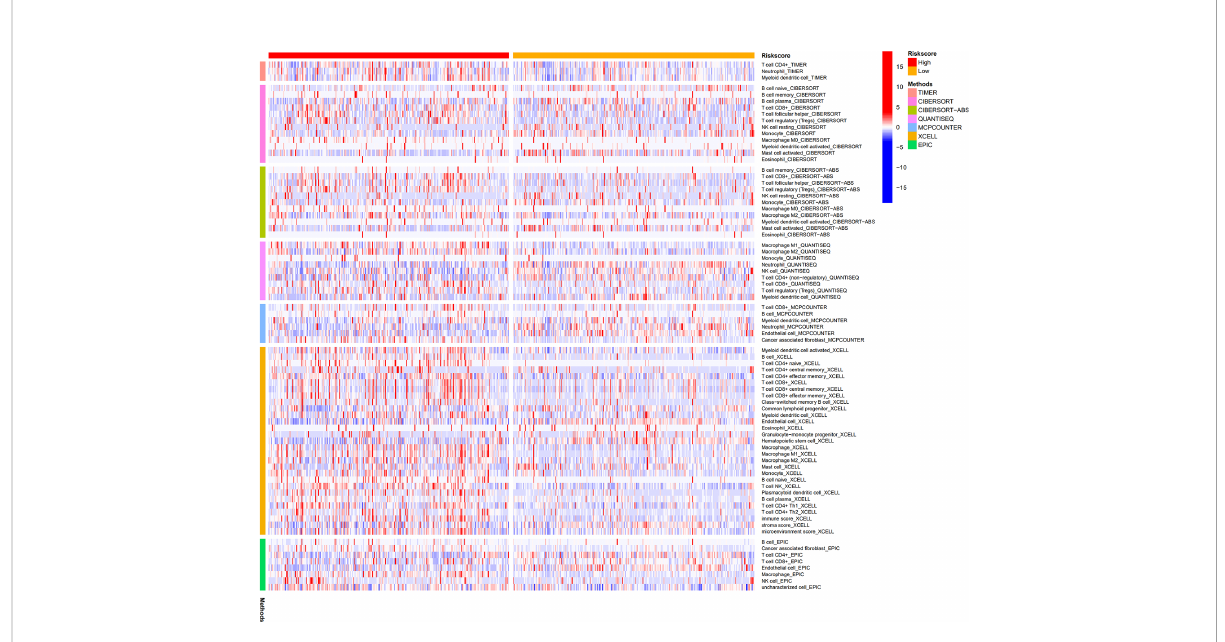
FIGURE 12 Differences in in fi ltration levels of immune cells between low- and high-risk patients.